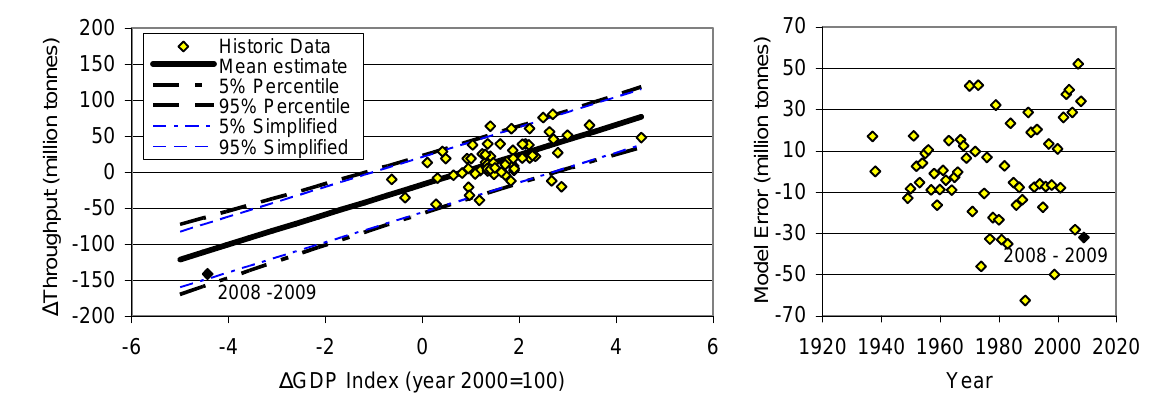
Figure 5. Linear Regression between differences of GDP and Port